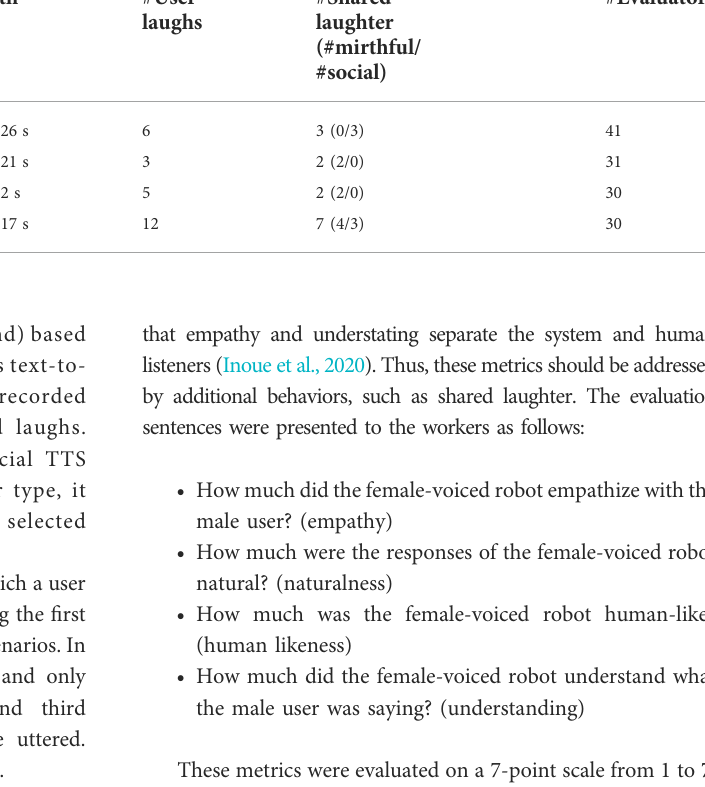
TABLE 5 Distribution of annotated samples on laughter type (social: number of people who annotated the sample as social; mirthful: number of people who annotated the sample as mirthful).